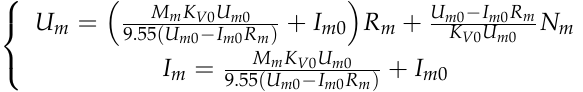
Figure 16. Step response curve of the servo motor. ×